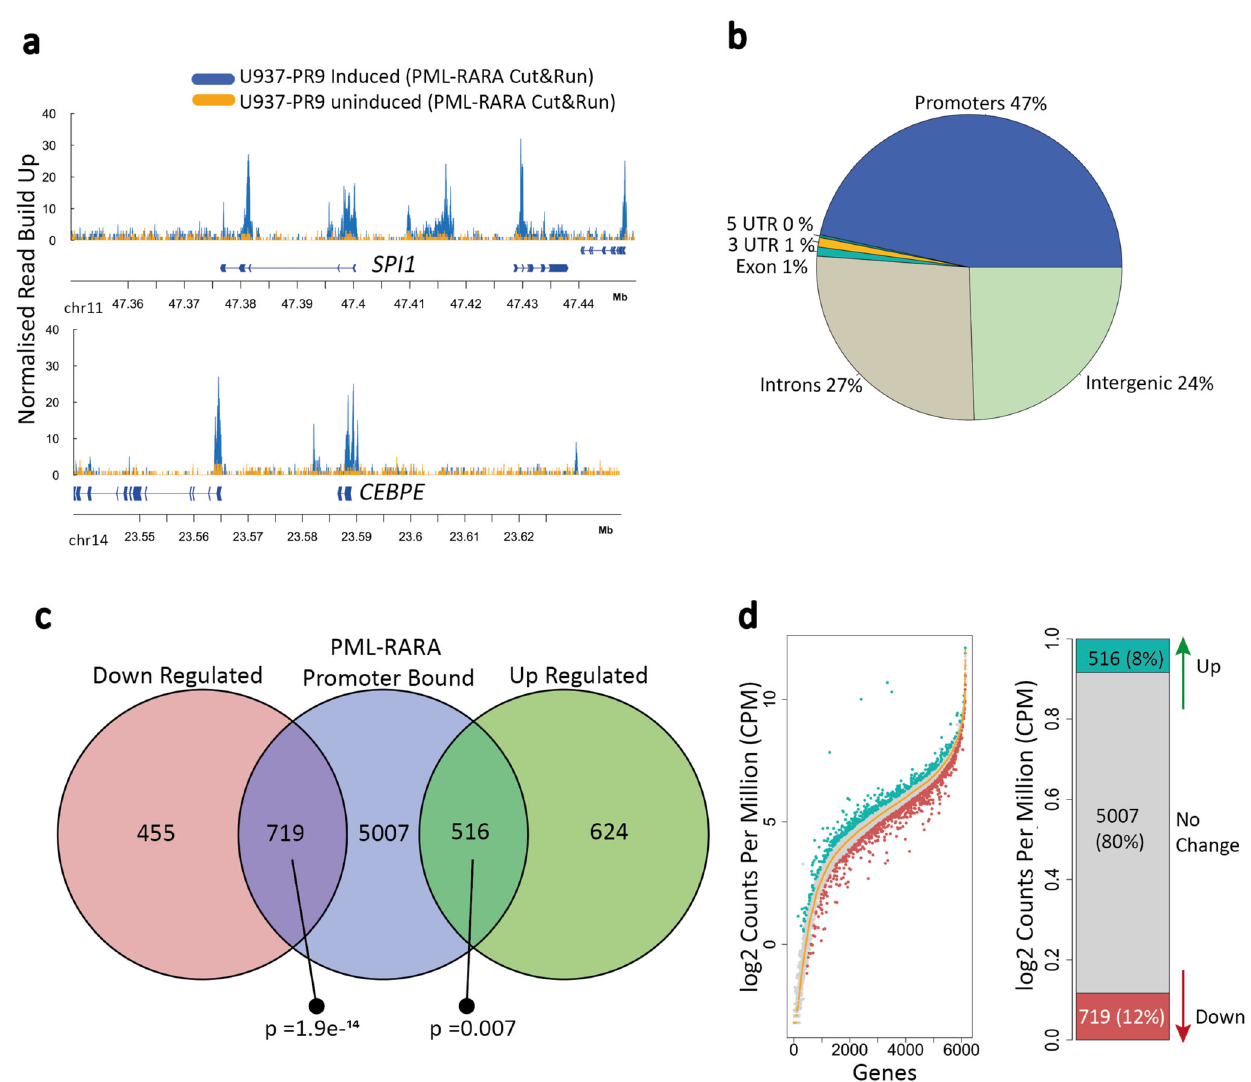
Fig. 2 | Varying transcriptional responses of genes whose promoters bind PML::RARA. a Genomic tracks of PML::RARA binding pro fi les at two key myeloid genes: SPI1 (top) and CEBPE (bottom). Normalized PML::RARA read density in uninduced (orange) and induced (blue) U937-PR9 cells are shown. Blue indicates the replicate #1 PML::RARA induced pro fi le and gold indicates the replicate #1 PML::RARA uninduced (background) pro fi le. Y-axis represents the read count normalizedbylibrarysize.Thegenomiccoordinatesareindicatedalongthex-axis. Gene bodies and exons are indicated by connecting blue blocks. b Pie chart showing the genomic distributions of all 15,412 PML::RARA peaks within pro- moters=blue, intergenic regions=light green, intronic regions=gray, exons= green and 3 ’ untranslated regions (3 ’ UTR)=orange. c Venn diagram overlapping the 6242 PML::RARA-promoter bound genes (blue) with upregulated (green) and